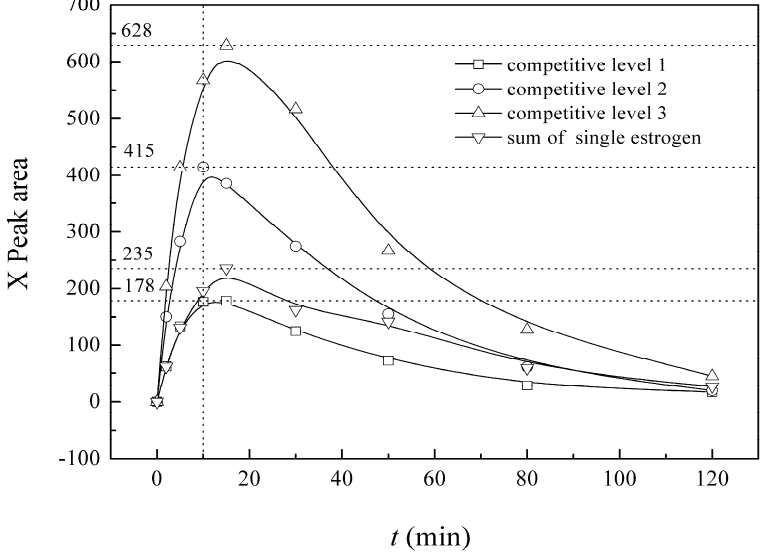
Figure 8. Variation of intermediate X under different simulated conditions in UV/H 2 O 2 system (competitive level 1: initial cosolute concentration C 0 of E1 = 45.2 μ g/L, E2 = 43.2 μ g/L and EE2 = 44.4 μ g/L; initial cosolute concentration C 0 of level 2: E1 = 86.3 μ g/L, E2 = 87.0 μ g/L and EE2 = 83.3 μ g/L; initial cosolute concentration C 0 of level 3: E1 = 135.3 μ g/L, E2 = 140.9 μ g/L and EE2 = 127.8 μ g/L; initial single estrogen concentration C’ 0 of E1 = 47.2 μ g/L, E2 = 44.3 μ g/L and EE2 = 41.0 μ